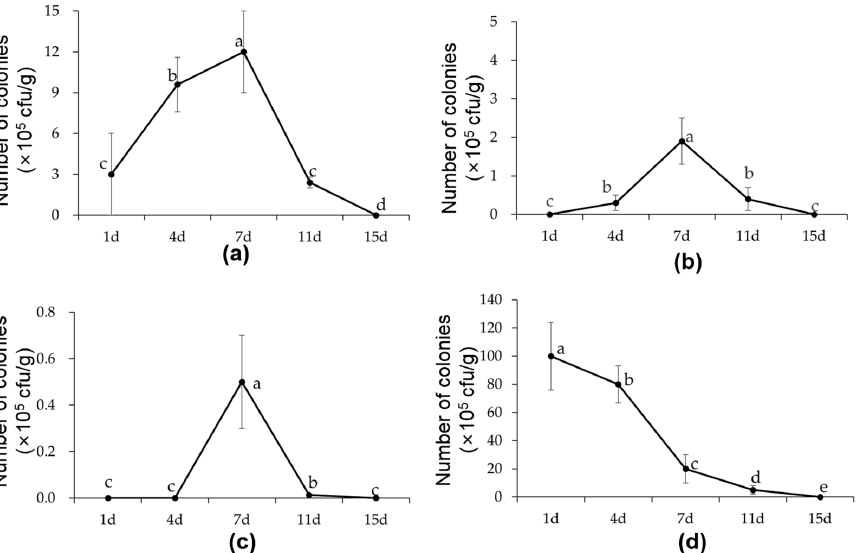
Figure 5. Colonization of B6 in the roots ( a ), stems ( b ), leaves ( c ) and rhizosphere soil ( d ) of cabbage seedlings. Different lowercases indicated statistical difference at p < 0.05.